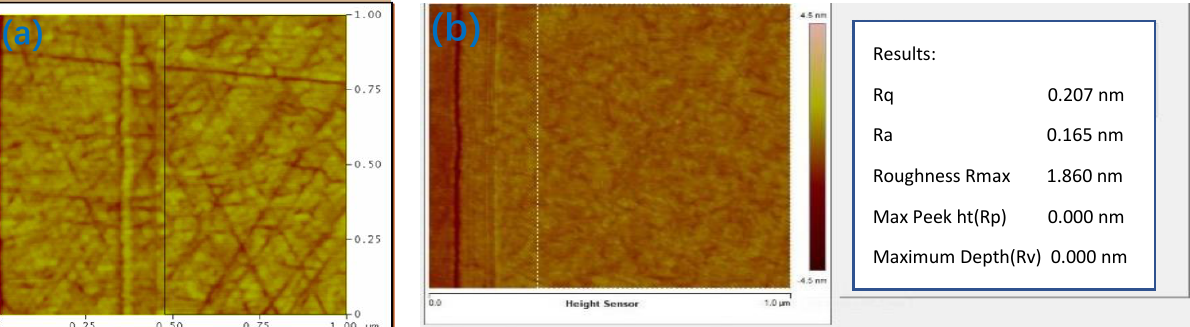
Figure 15. Keyence images of diamonds of different sizes embedded in a plate: ( a ) normal size slurry; ( b ) ultrafine slurry.